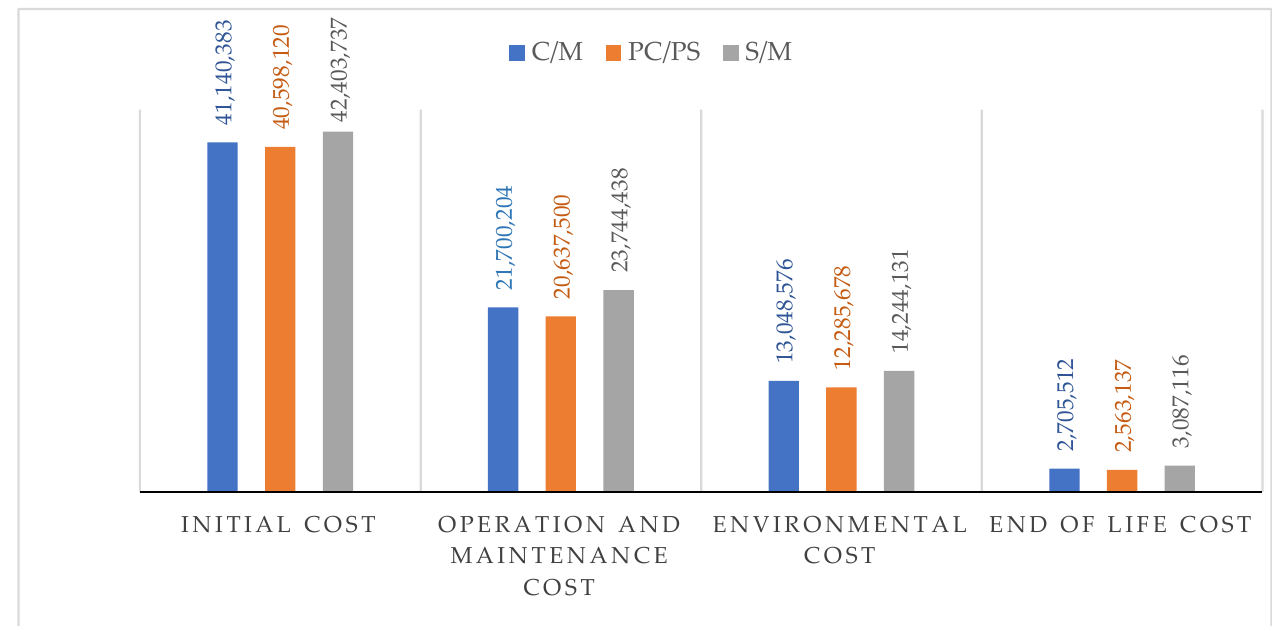
Buildings 2022 , 12 , x FOR PEER Scheme 1 . The LCC component values of the various alternatives for the case study. Scheme 1. The LCC component values of the various alternatives for the case study.